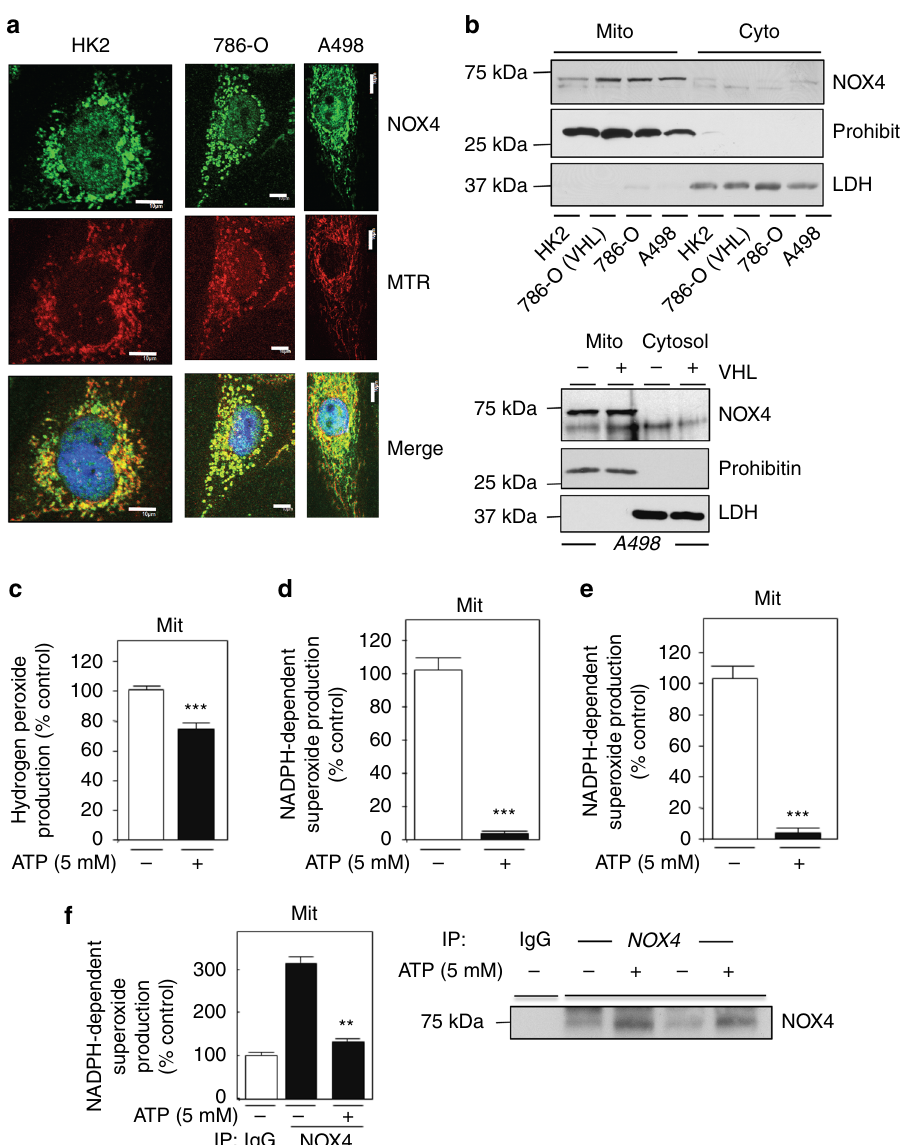
Fig. 2 NOX4 localizes to the mitochondrial compartment and is inhibited by ATP. Subcellular localization of NOX4 was assessed in normal renal epithelial cells, HK2, and von Hippel Lindau (VHL)-de fi cient renal carcinoma cells (RCCs), 786-O and A498 by confocal microscopy as described 8 . a Indicated renal cells were labeled with mitotracker red (MTR), fi xed, and stained with NOX4 (Novus49) antibody followed by FITC-linked donkey anti-rabbit secondary antibody. Nuclei were counter stained with DAPI. Merge in yellow shows colocalization. Scale bar 10 μ M. b HK2, 786-O (with or without VHL), and A498 cells (upper panel) or A498 with or without VHL (lower panel) were subjected to pierce kit fractionation as per the manufacturer ’ s instructions to yield mitochondrial or cytosolic fractions. NOX4 expression was assessed by western blot analysis. Prohibitin was used as a marker for mitochondria, whereas lactate dehydrogenase (LDH) was used as a marker for cytosol. c Hydrogen peroxide was measured in mitochondrial fractions as prepared, detailed in Methods, and was incubated with (+) or without ( − ) exogenous 5 mM ATP using Amplex Red reagent. The results are from two independent experiments with an n = 4 in each experiment. NOX activity was measured in crude mitochondrial homogenates with (+) or without ( − ) 5 mM ATP in both d 786-O and